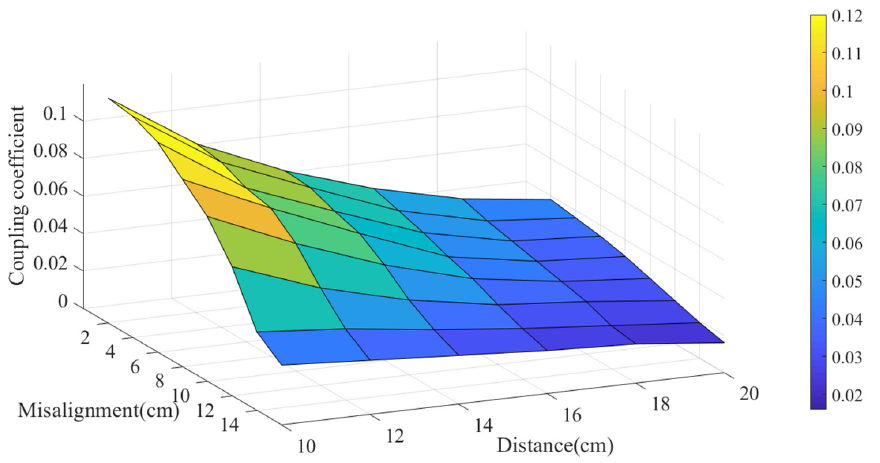
Figure 8. ( a ) 𝑘 (cid:2870)(cid:2871) versus transmission distance; ( b ) 𝑘 (cid:2870)(cid:2871) versus misalignment when distance is 10 cm.